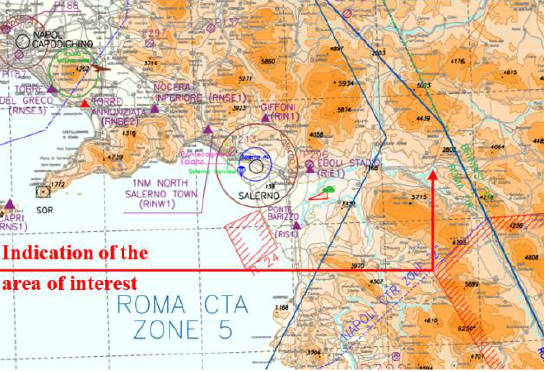
Figure 5. Indication of the AOI on VFR